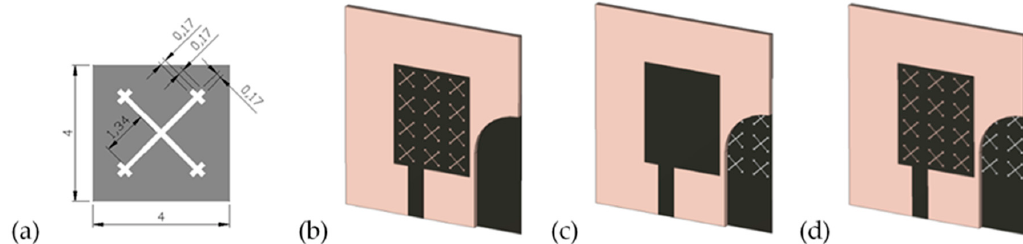
Figure 2. ( a ) the crossbar fractal based elementary unit cell of the antenna (dimensions are in mm); ( b – d ) geometry of the three configurations (mentioned in the text) of microstrip antennas with crossbar fractals.